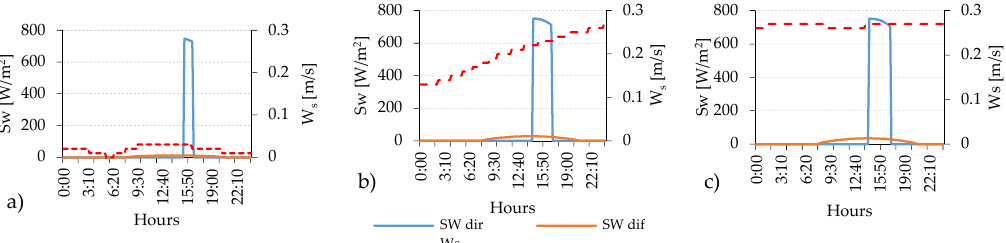
Figure 7. The hourly evolution of the typical trend (R04) of short-wave direct (Sw dir) and diffuse (Sw dif) irradiation and the W s at pedestrian level within the ( a ) compact low-rise, ( b ) compact mid-rise and ( c ) open-set high-rise urban canyons.